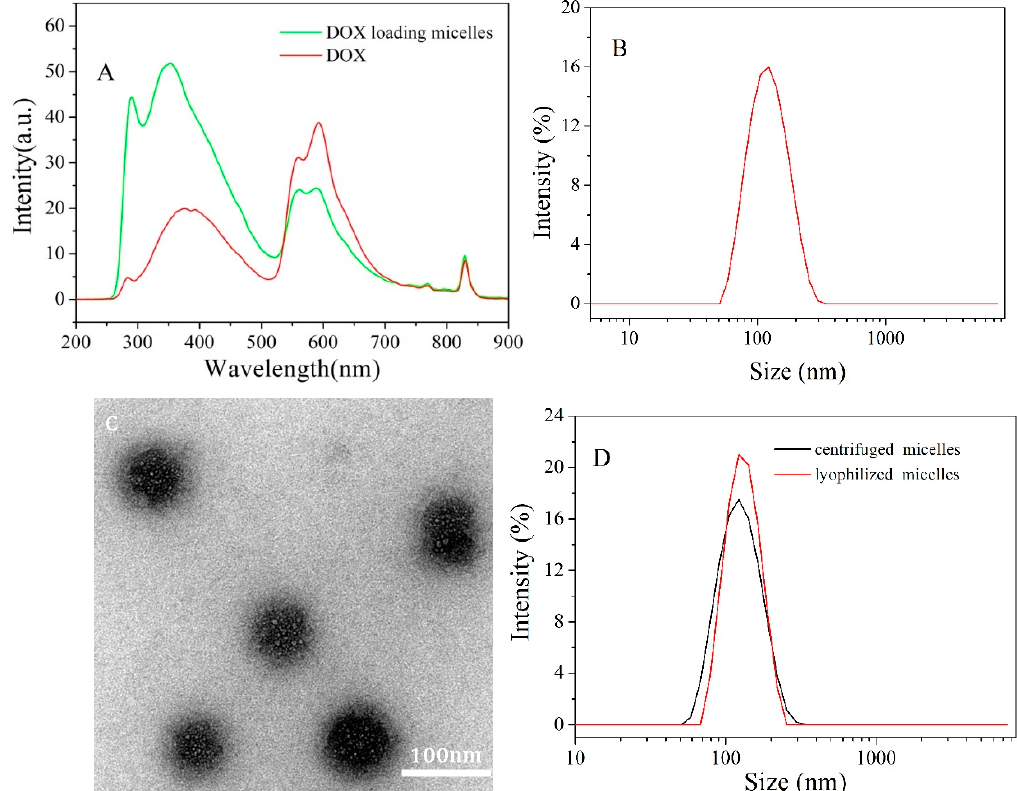
Figure 4. The fluorescence spectra of DOX and DOX loading micelles in PB ( A ); hydrodynamic diameter distribution f ( D h ) ( B ) and TEM image ( C ) of DOX-loaded micelles; hydrodynamic diameter distribution f ( D h ) of resuspended DOX-loaded micelles after treated by centrifugation and lyophilization ( D ).